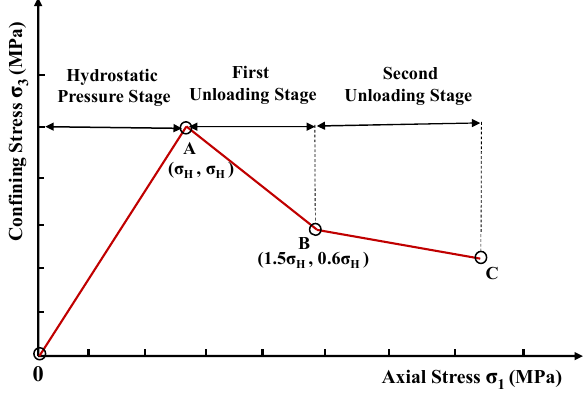
Figure 3. Stress path diagram for the triaxial unloading experiment [32,33]. Table 1. Triaxial unloading testing program of coal samples at different depths. Depth